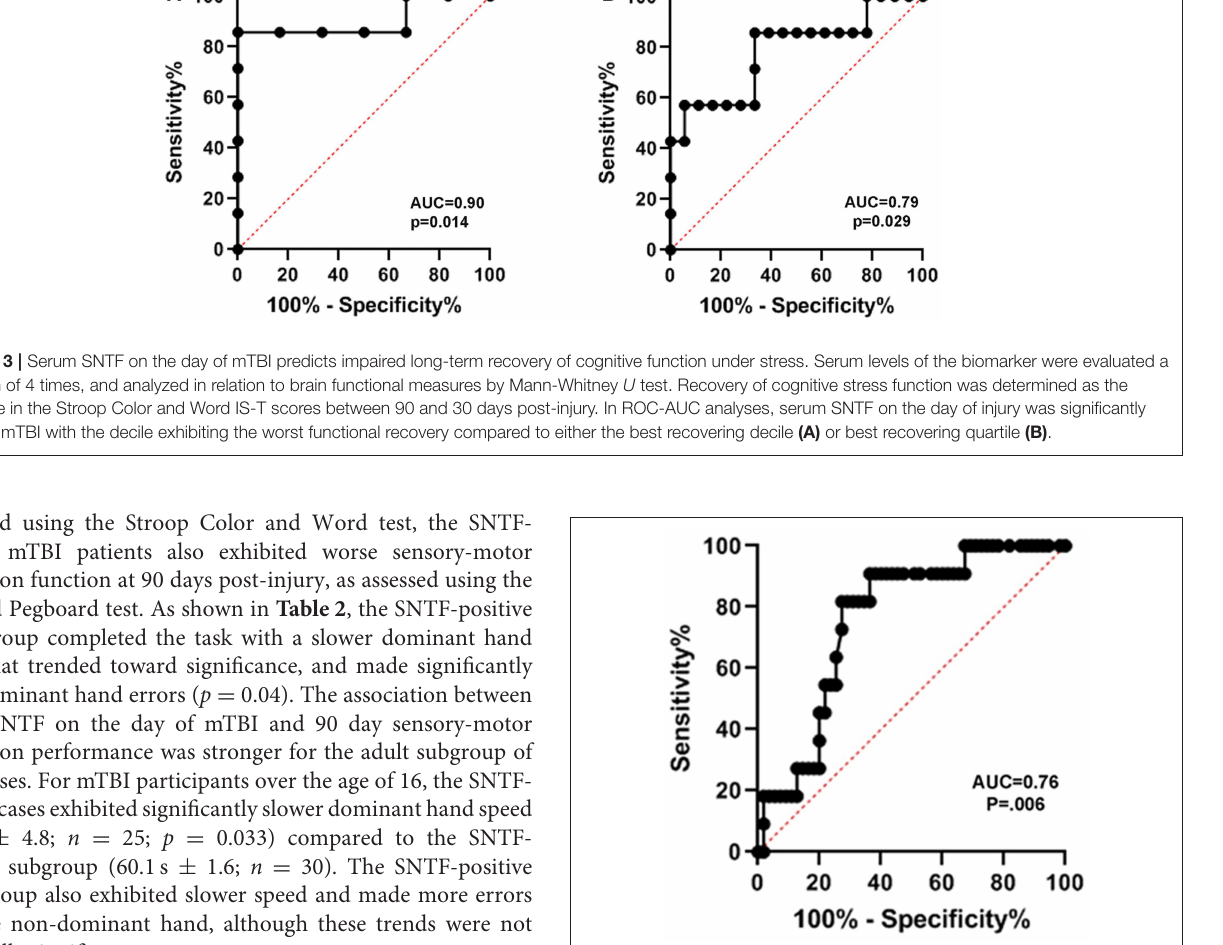
either negative ( n = 80) or not indicated ( n = 15), serum levels